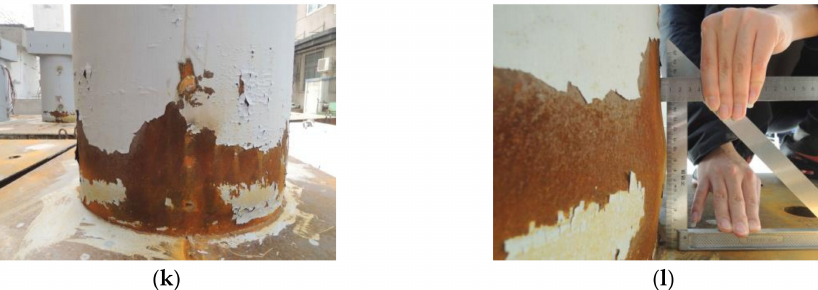
Figure 6. Failure modes of specimens. ( a ) failure of CFST-N; ( b ) detailed measurement of CFST-N; ( c ) failure of CFST-HS; ( d ) detailed measurement of CFST-HS; ( e ) failure of CFST-VS; ( f ) detailed measurement of CFST-VS; ( g ) failure of CFST-SR; ( h ) detailed measurement of CFST-SR; ( i ) failure of CFST-DT; ( j ) detailed measurement of CFST-DT; ( k ) failure of CFST-MC; and ( l ) detailed measurement of CFST-MC.